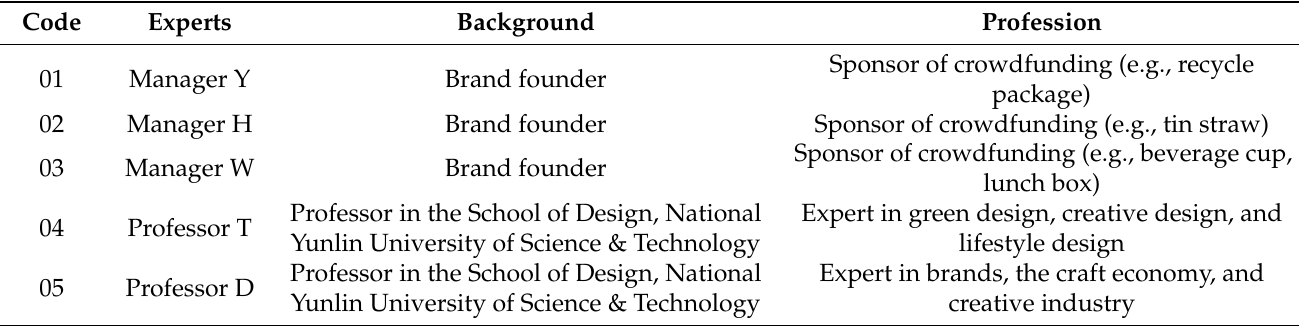
Table 3. Composition of